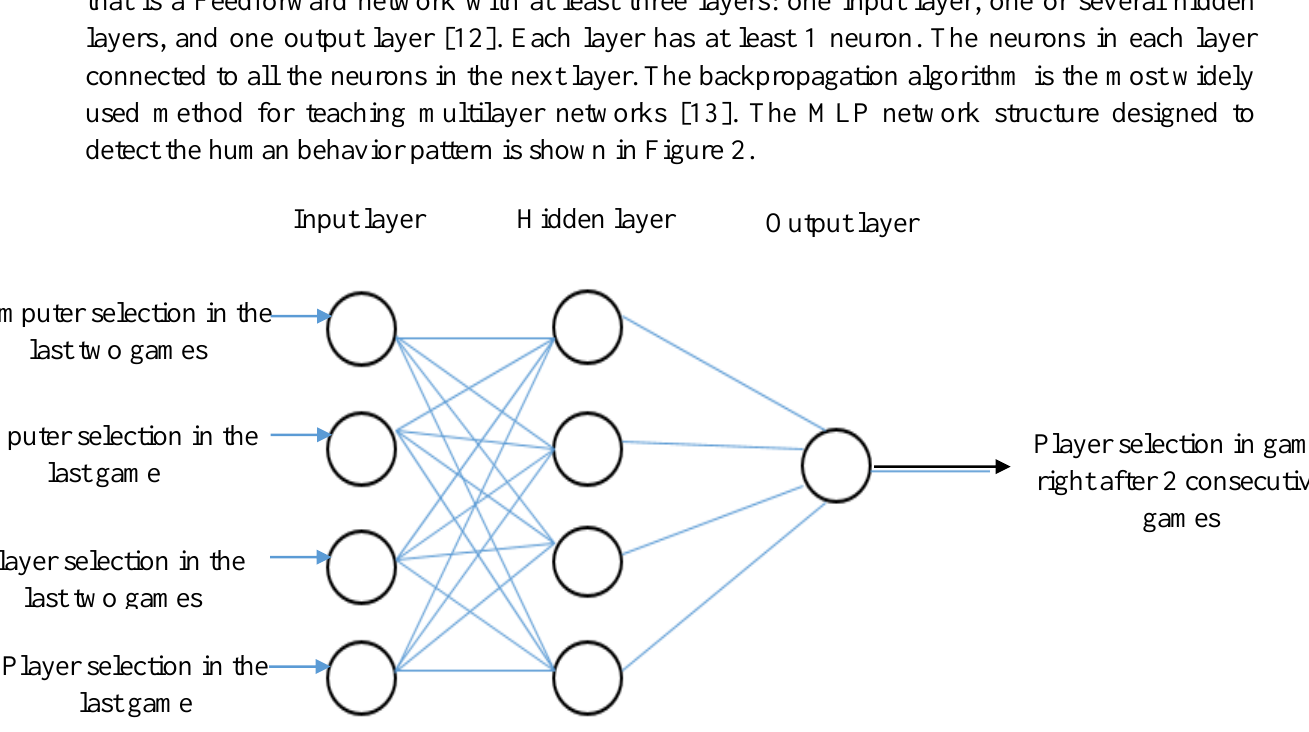
Fig. 2. MLP network structure designed to detect human behavior